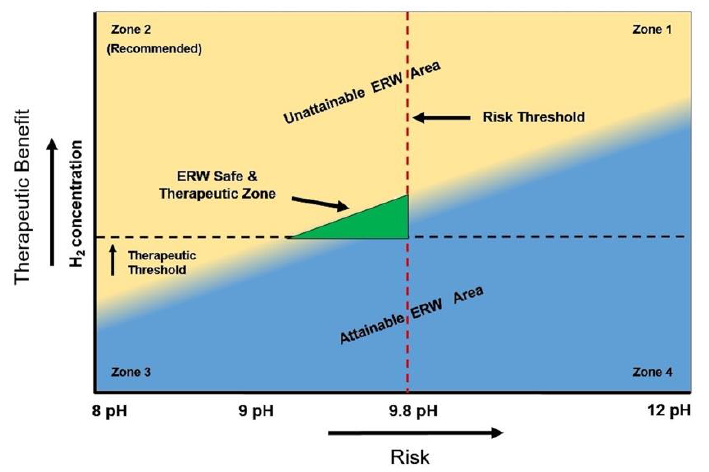
Figure 1. Representation of the risk-to-benefit ratio of ERW in making dissolved hydrogen gas and potential health risks. The ERW range only overlaps a small portion of the recommended zone 2 in which the H 2 concentration is sufficient, and the risks are minimized.